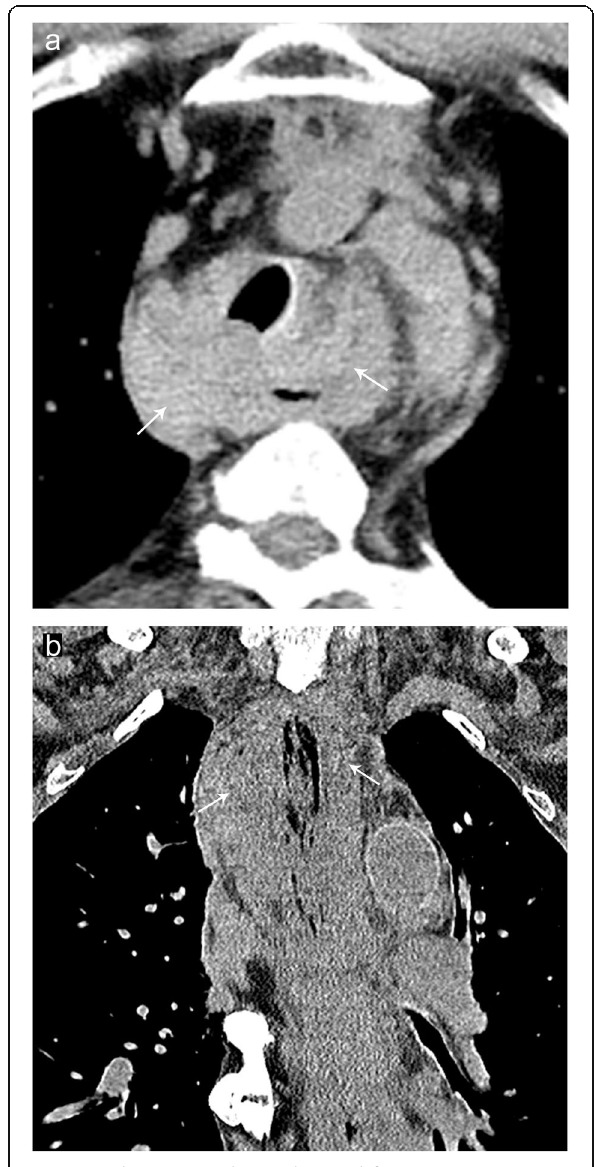
Fig. 10 Mediastinitis. Axial ( a ) and coronal ( b ) noncontrast CT images demonstrating inflammatory changes and soft tissue stranding (arrows) of the mediastinum secondary to mediastinitis. Note the associated diffuse thickening of the esophageal wall in this patient with suspected esophageal wall